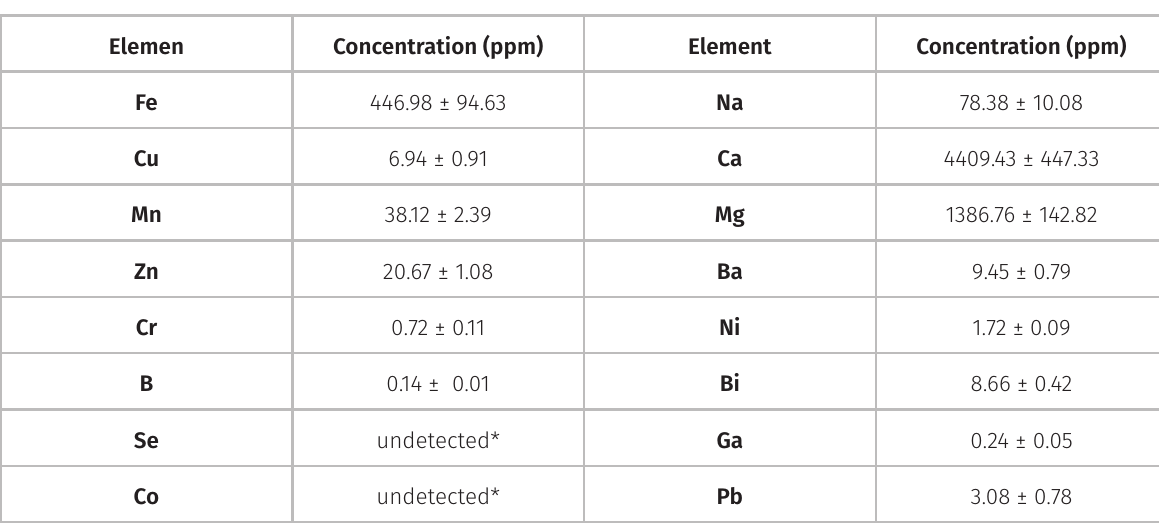
Table III. The element levels in the Verbascum lasianthum Boiss. ex